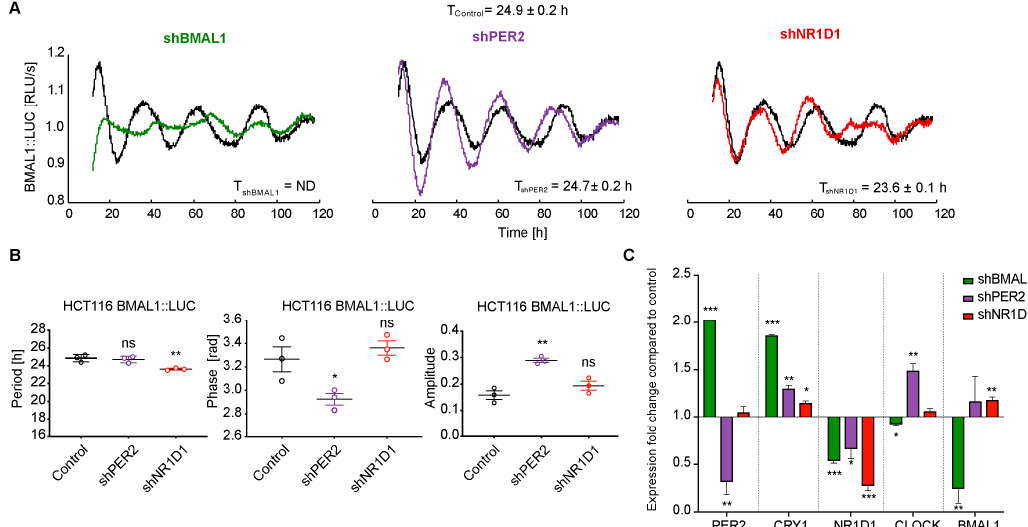
Figure 1. BMAL1 promoter activity shows different oscillation patterns in HCT116 knockdown cell lines. ( A ) Bioluminescence readouts for the promoter activity of BMAL1 over the course of 120 h in HCT116 control and knockdown ( shBMAL1 , shPER2 and shNR1D1 ) cell lines. Periods were calculated with ChronoStar software (T Control = 24.9 ± 0.2 h, T shBMAL1 = ND, T shPER2 = 24.7 ± 0.2 h, T shNR1D1 = 23.6 ± 0.1 h, n = 3, mean ± SEM). ( B ) Period, phase and amplitude analysis of circadian bioluminescence data of HCT116 knockdown cells over the course of 120 h using Chronostar. ( C ) Gene expression analysis of core-clock genes PER2 , CRY1 , NR1D1 , CLOCK , and BMAL1 in HCT116 control and knockdown cell lines at 24h after synchronisation. ND, not defined, ns or no asterisk p > 0.05, * p < 0.05, ** p < 0.01, *** p < 0.001; two-tailed unpaired t -test.